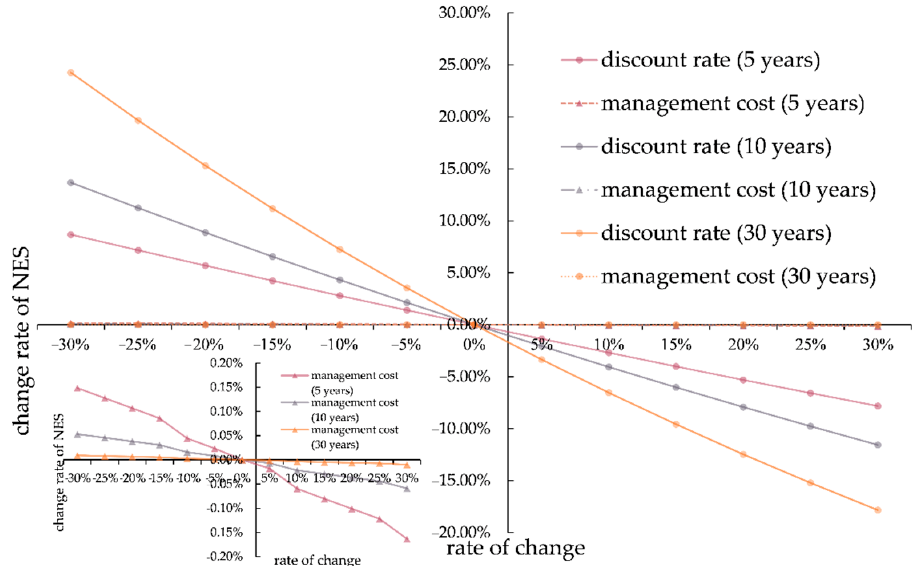
Figure 7. Sensitivity analysis for discount rate, management cost and period of investment return to NES. The red, gray and yellow lines indicate 5, 10, and 30 years periods of investment return, respectively. Circle markers indicate the discount rate and the triangle markers indicate management cost.